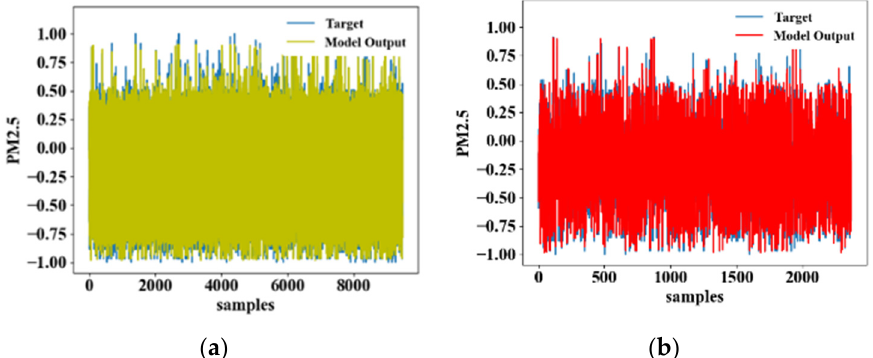
Figure 15. Learning results of the RBF neural network model: ( a ) training set and ( b ) testing set. Table 2. RMSE values of the four adopted learning models. Model Data Pre Processing